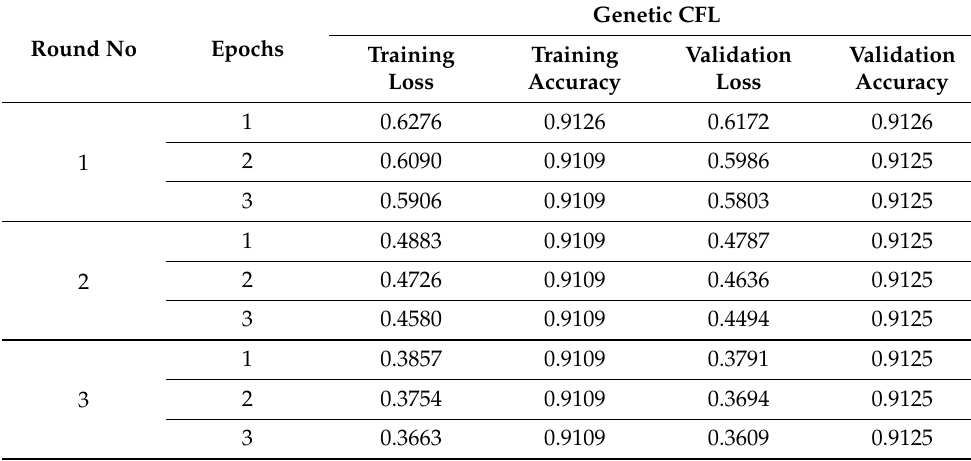
Table 6. Accuracy and loss of genetic CFL in several